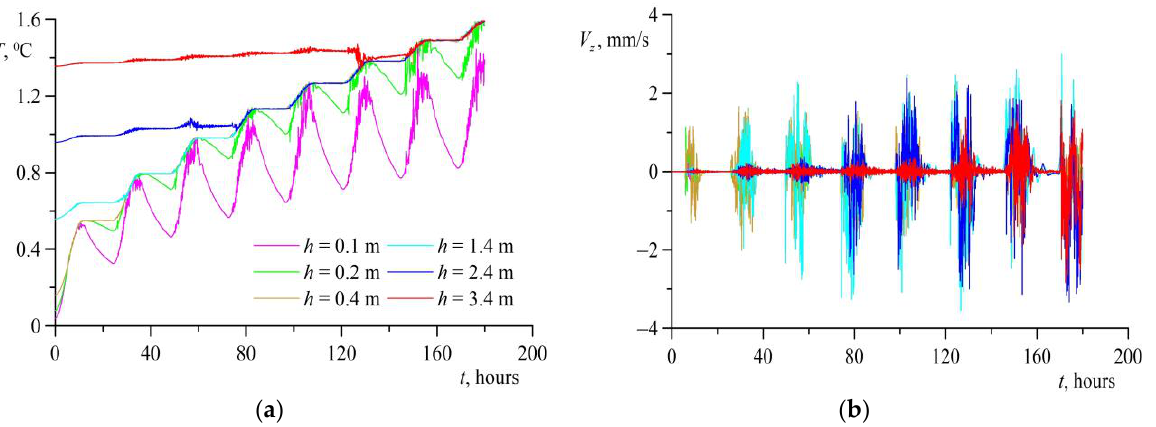
Figure 3. Time evolution of the water temperature ( a ) and vertical velocity component ( b ) at different depths (Variant 1).